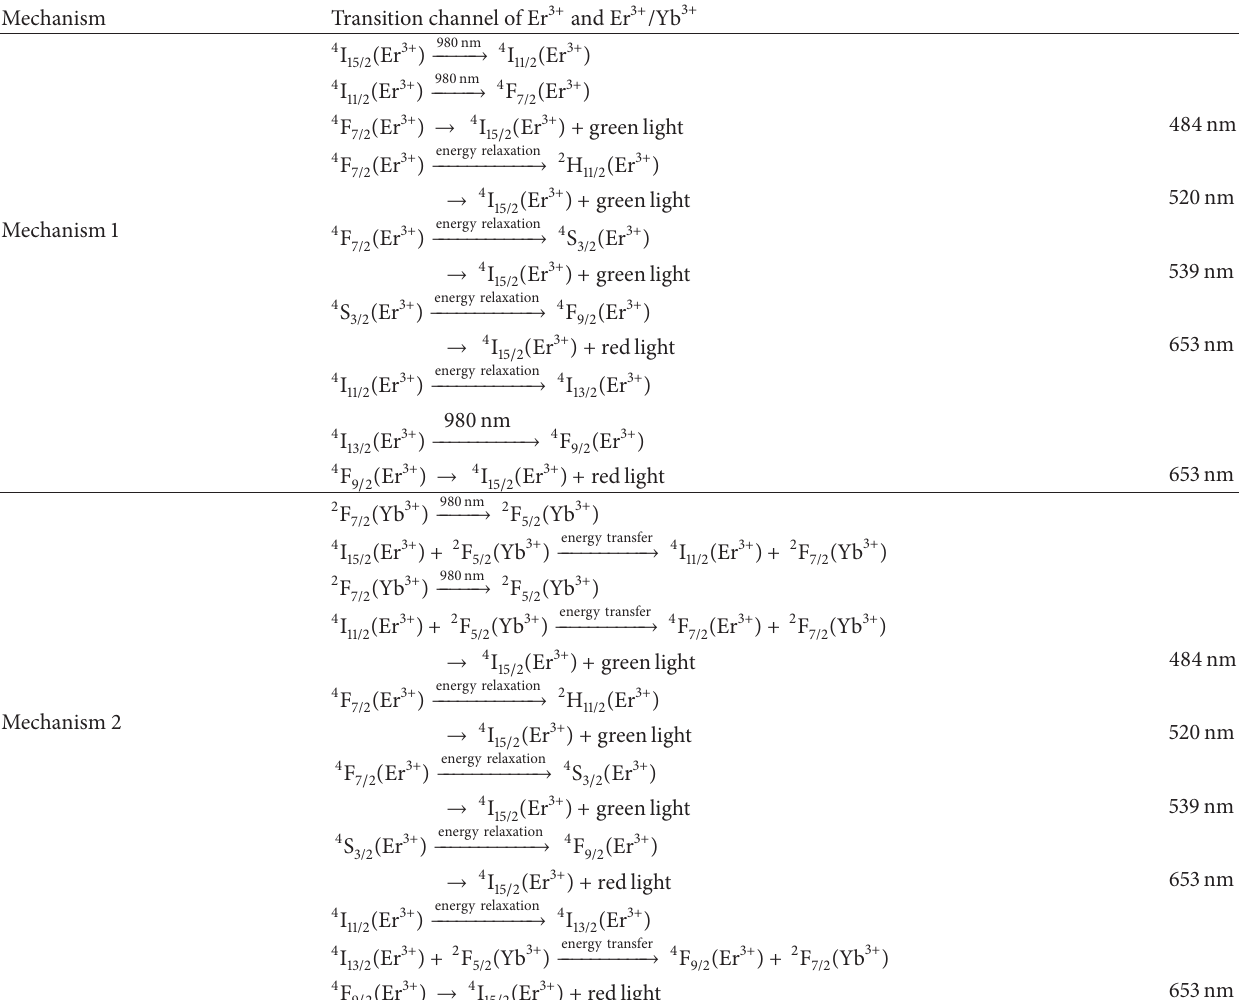
Table 2: Sequential two-photon exciting upconversion transition channels for Er 3+ doped or Er 3+ /Yb 3+ codoped nanocrystals.